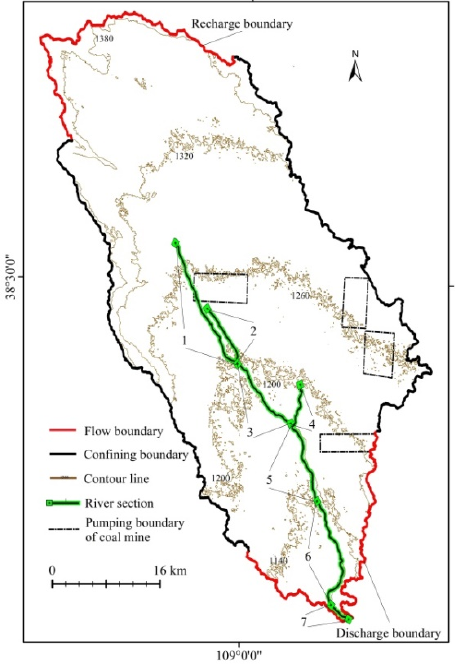
Figure 4. Division of recharge and discharge areas in the